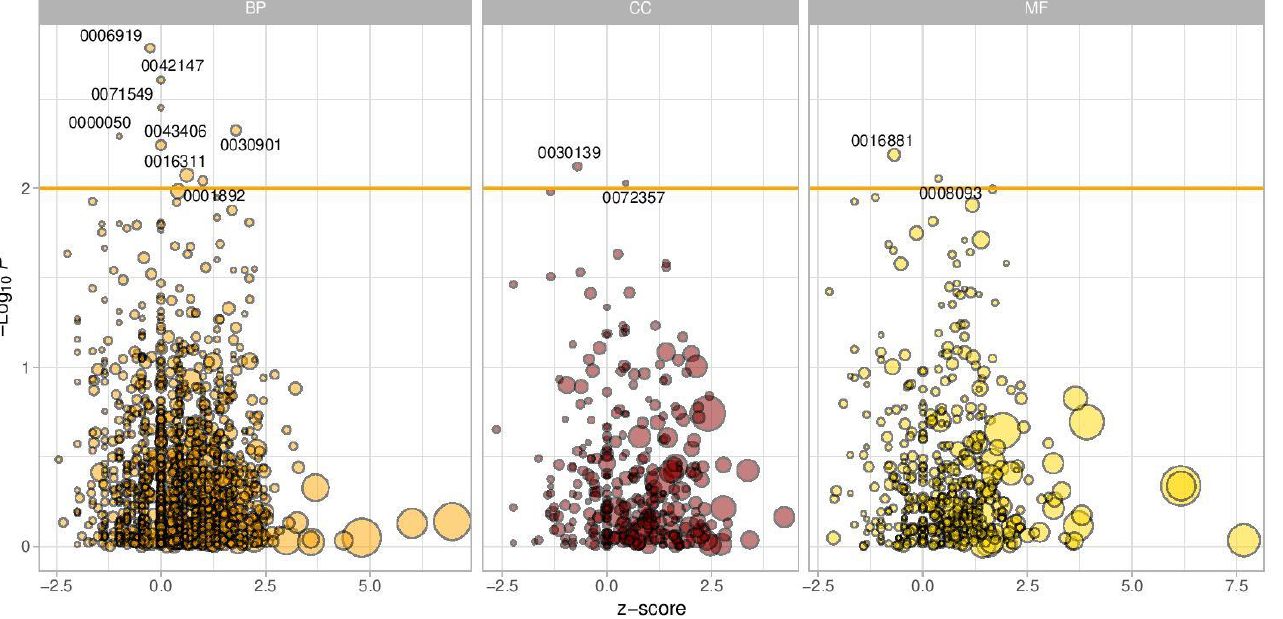
Figure 2. Gene Ontology analysis. Volcano plot of results from enrichment analysis of pathways from Gene Ontology. Z-score is defined as the number of hypermethylated genes minus the number of hypomethylated genes in the pathway, divided by the square root of the number of total genes. A positive Z-score indicates hypermethylation in Group B, while a negative Z-score indicates hypomethylation in Group B. Orange vertical line indicates a p -value of 0.01. Gene sets with a p -value less than 0.01 are labeled with GO ids. The point size shows the number of genes with methylation information in each pathway. BP: biological process: CC: cellular component; MF: molecular function.